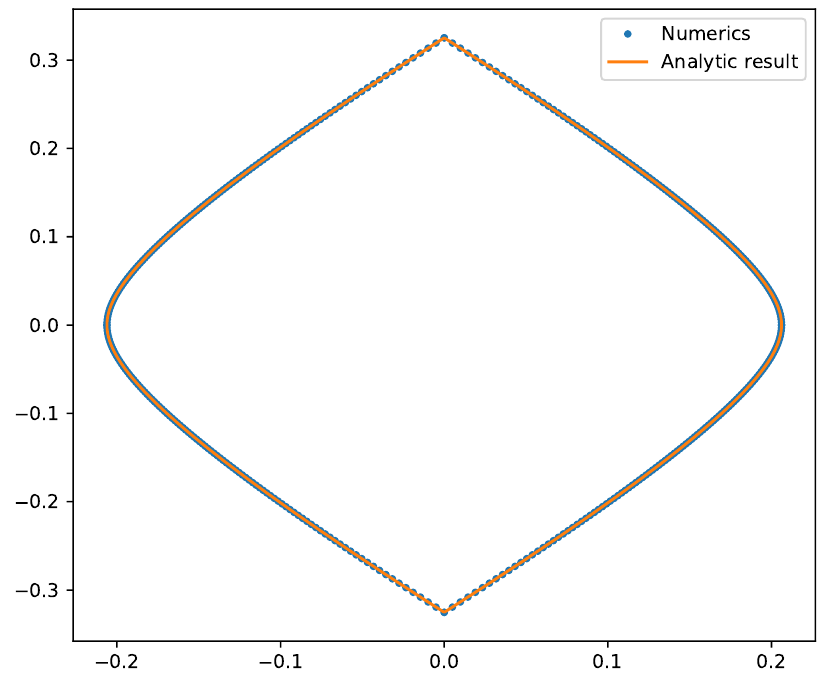
Figure 7 . Allowed values of A ( θ 1 ) , B ( θ 1 ) for θ 1 = 0 . 9879 i . The solid curve is the analytic result and the points are the numerical data. All points of the curve correspond to the same integrable R-matrix that has a free parameter α that changes along the boundary, see eq. (1.29). The vertex corresponds to the limit α → ∞